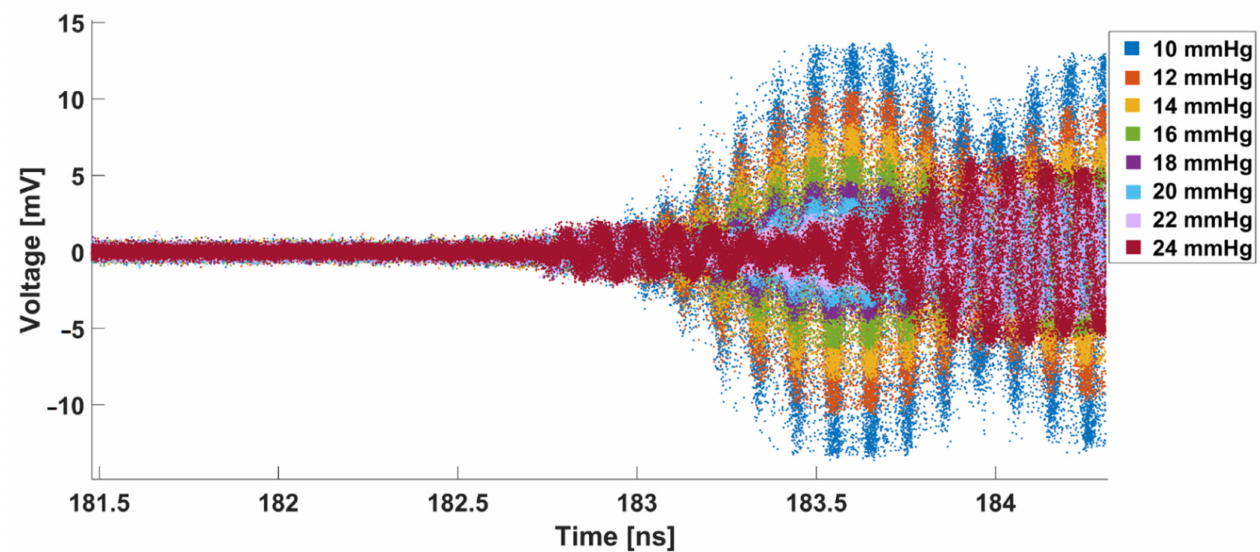
Figure 4. Raw transient signals reflected from the abdominal wall phantom at different IAP values. The reflection response between 181.5 and 182.5 ns is almost zero since there was a distance between the transmitter antenna and the front side of the abdominal wall phantom. Consequently, no reflection happened at this interval. At 182.7, however, the reflection response starts to increase, which means that the first group of reflected waves has been detected by the receiver antenna. Afterwards, more reflected waves from deeper layers of the abdominal wall phantom have been detected and the reflection response has increased progressively.